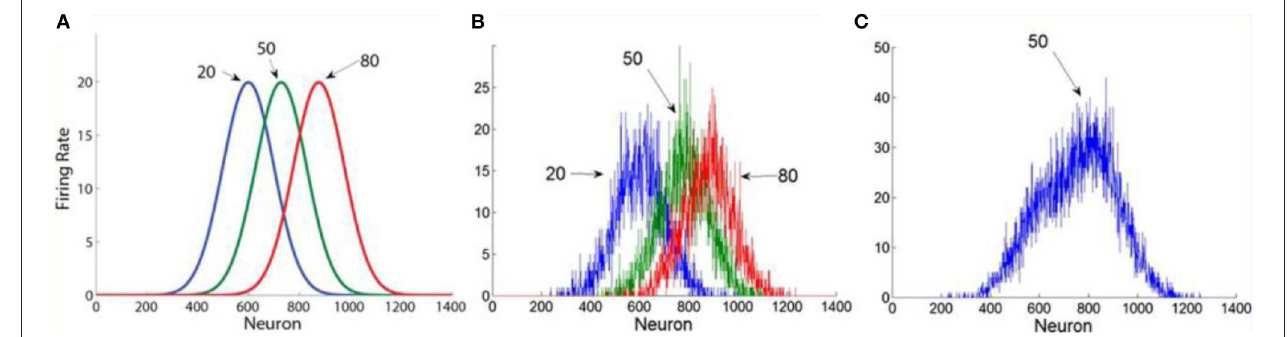
FIGURE 1 | The population averaging model. (A) Numbers activate broadly tuned number- magnitude detectors. (B) In this illustration we show the noisy population profile in response to the presentation of an example sequence of 3 numbers: 20, 50, 80. (C) The estimation of the average is based on the central of mass of the population response (reproduced from Brezis et al.,